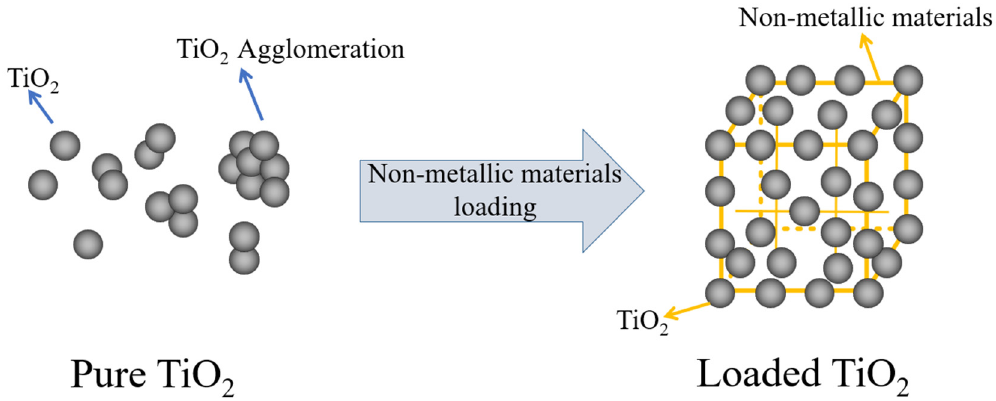
Figure 1. The schematic diagram of non-metallic materials loading TiO 2 .